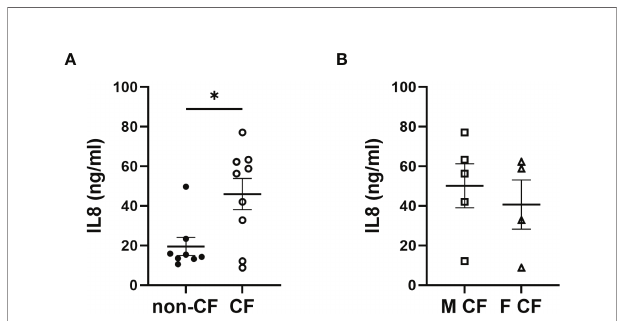
FIGURE 5 | Interleukin 8 (IL8) secretion. (A) Comparison of IL8 secretion in hNEC cell culture medium between samples derived from non-CF and CF subjects and